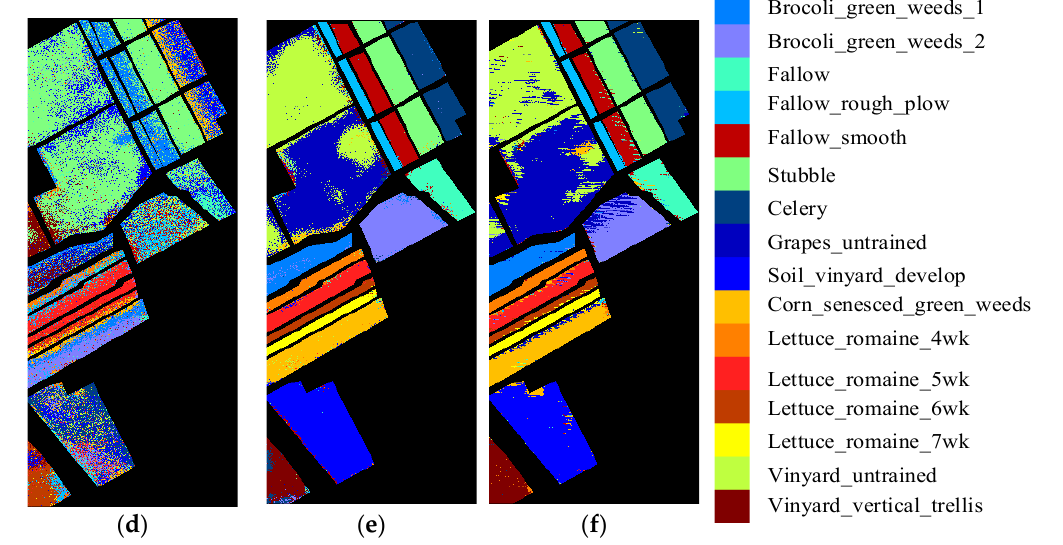
Figure 17. Classification maps of different model (training sample = 10) on the SA dataset. ( a ) Ground-truth map. ( b ) HybridSN. ( c ) MAPC. ( d ) MFFN. ( e ) DC-CNN. ( f ) DSEN.